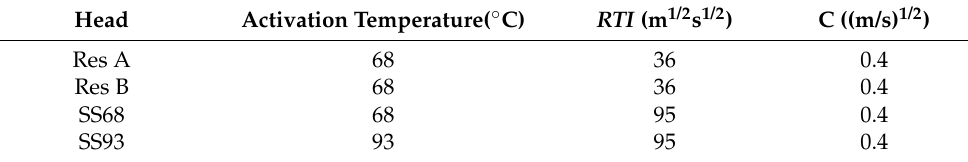
Table 1. Sprinkler heads